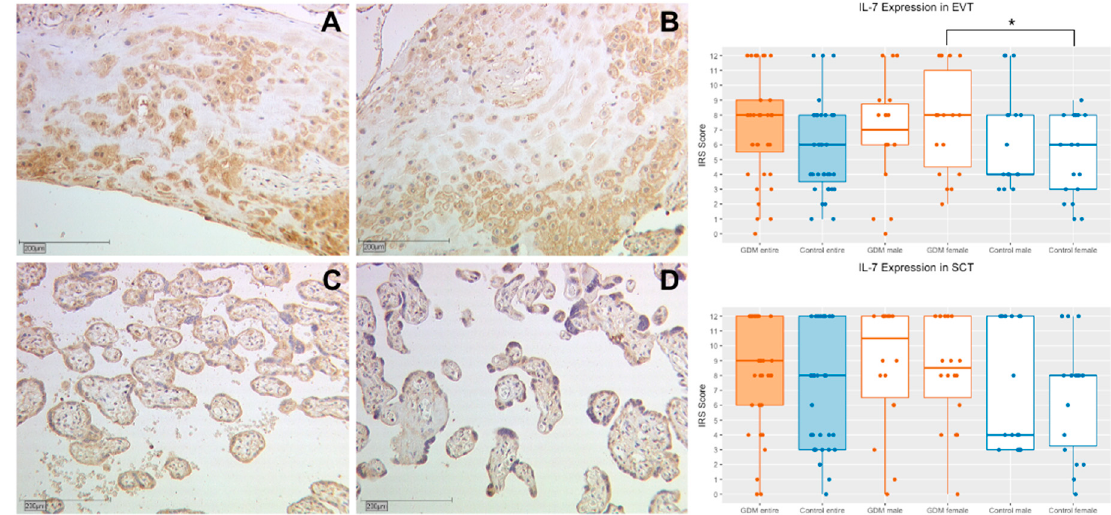
Figure 1. Representative immunohistochemical staining for IL-7 in extravillous trophoblast (EVT) in placentas of women with gestational diabetes mellitus (GDM) and the control group at a magnification of 10×. Staining of the EVT in a placenta affected by GDM ( A ) and of the control group ( B ). IL-7 expression of the syncytiotrophoblast (SCT) in placentas with GDM is demonstrated in image ( C ) and of the control group in image ( D ). The quantification of the IL-7 expression in placentas (with use of the IRS) of the study and control group and also their subgroups is shown in the box plots. Orange boxes represent the GDM group and blue boxes the control group. The range within the boxes represents the values between the 25th and 75th percentile with a horizontal line at the median. The T-bars extend 1.5 times of the interquartile range, or if no value is in that range, to the minimum or maximum value. The dots are marking the value of each data point. Significant results are linked with lines and marked with an asterisk ( p < 0.05: *).